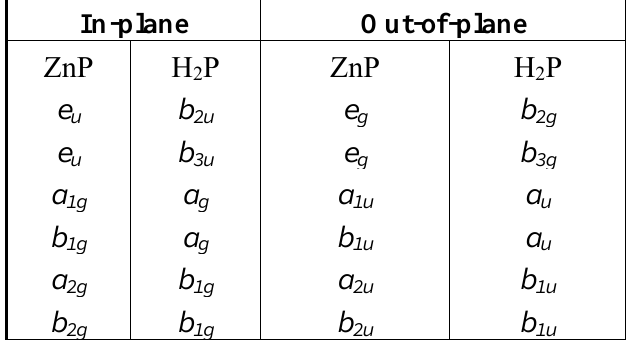
Table 2. Correlation of vibrational symmetry between ZnP ( D